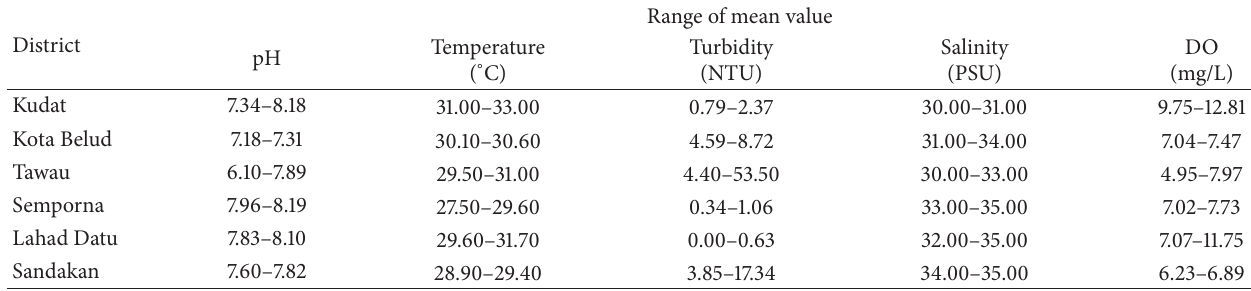
Table 6: Range of mean values of in situ physicochemical parameters (pH, temperature, turbidity, salinity, and dissolved oxygen) among 29 sampling sites in six districts.